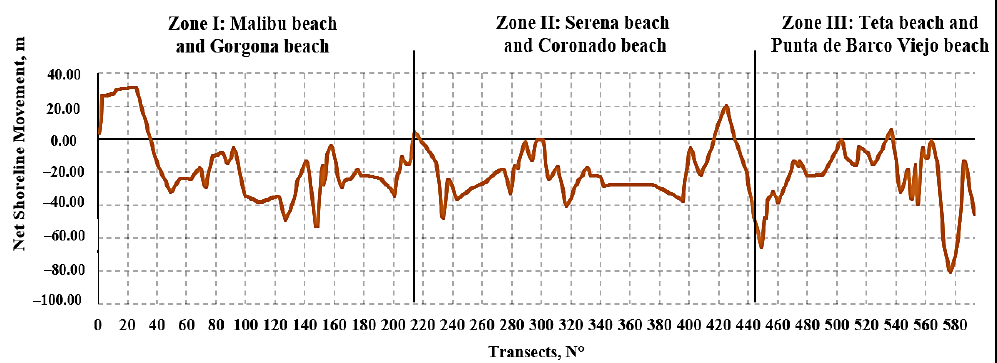
Figure 10. Net shoreline movement (NSM) recorded for each transect for the period from 1998 to 2021. Table 6. Summary of the results obtained for the long-term